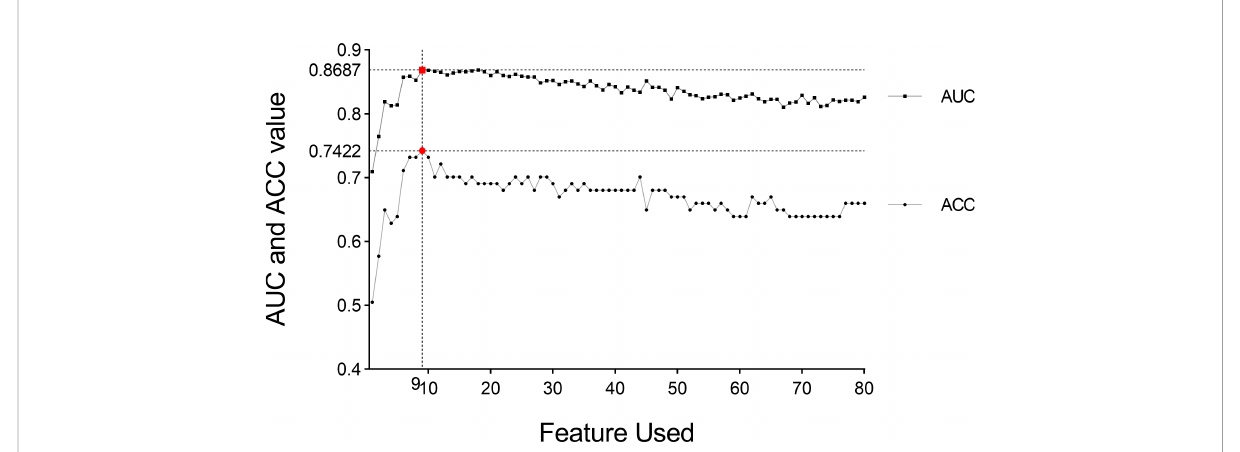
FIGURE 4 AUC value and diagnosis accuracy constructed with the number of used features. The optimal feature number was 9 with the highest ACC value of 74.22% and AUC value of 86.87% in Model 6. Moreover, the respective AUC values of IPMN, SCN, and MCN have also reached 0.9083, 0.8622, and 0.8356 (Figure 7). We fi nd that the overall predictive rate was 74.23% and the predictive rates in IPMNs, SCNs, and MCNs were 74.26%, 78.37%, and 68.00%, respectively. Confusion matrix was also drawn in Figure 7. The sensitivity (SEN) rates of IPMN, SCN, and MCN were 74.29%, 78.38%, and 68.00%. The speci fi city (SPEC) rates of IPMN, SCN, and MCN were 91.94%, 81.67%, and